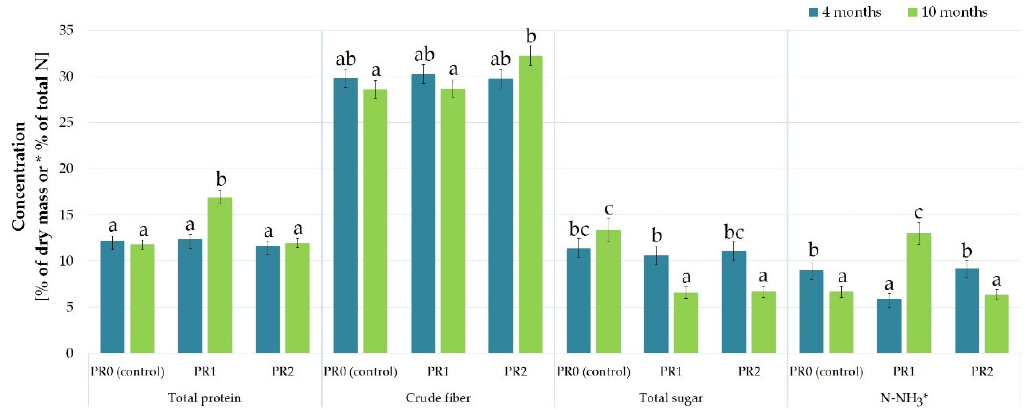
Figure 10. Silage parameters in the second stage of the experiment during storage for 4 and 10 months. Bars marked with the same letters indicate no statistical difference ( p < 0.05); results were analyzed separately for each parameter, * for ammonia nitrogen the concentration was presented as % of total nitrogen.